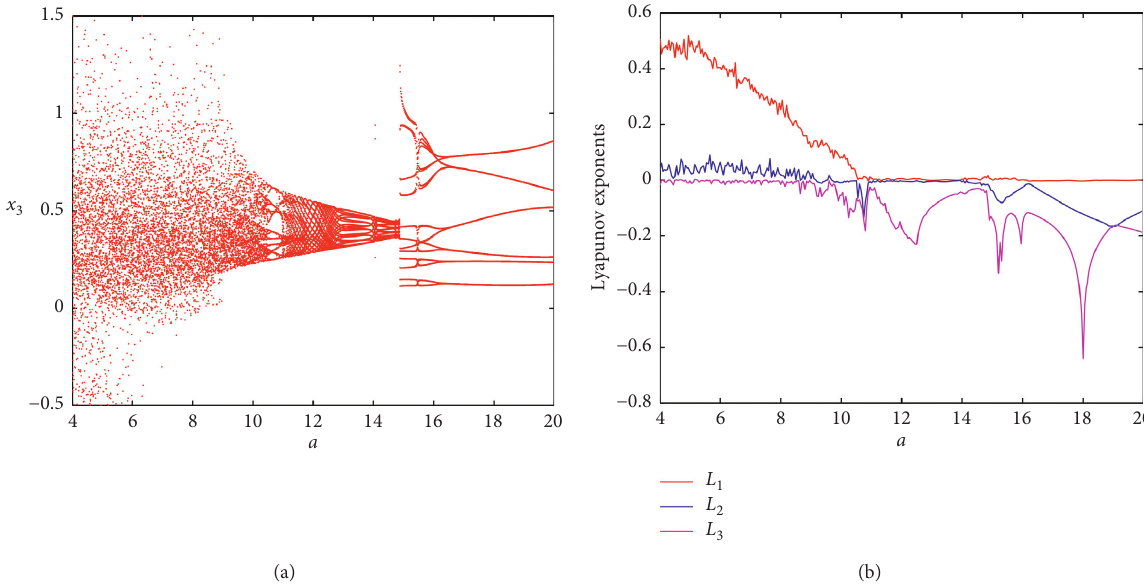
Figure 1: Bifurcation diagram and Lyapunov exponent of system (2) versus a ∈ [ 4 , 20 ] from initial value ( 1 , 1 , 1 , 1 ) , where L are Lyapunov exponents of system (2) and L